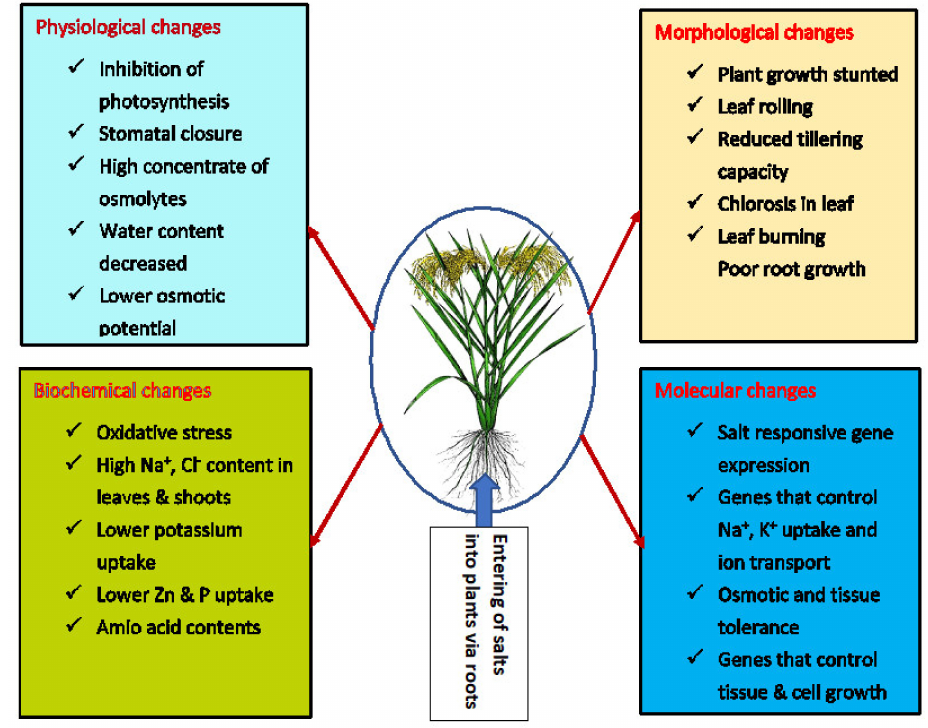
Figure 1. The effect of salt stress on rice physiological, biochemical, and molecular